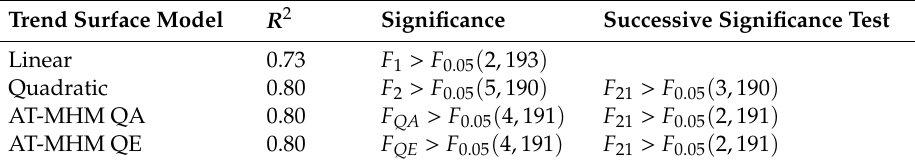
Table 4. Statistical test results of four types of fitting trend surfaces of grid (318, 10).